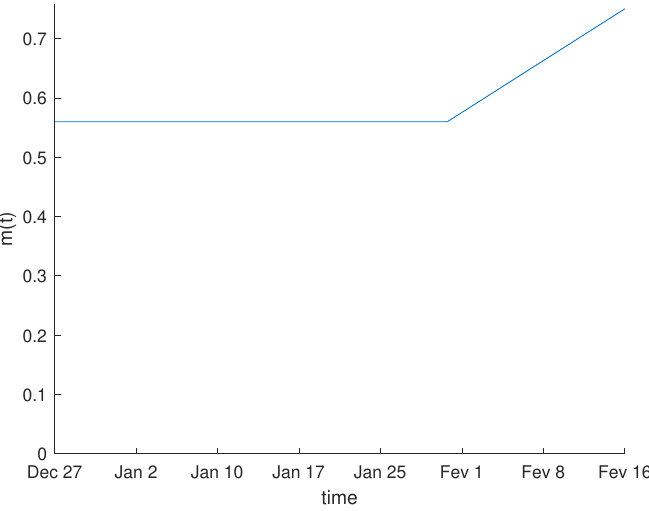
Figure 2. Evolution function m ( t )